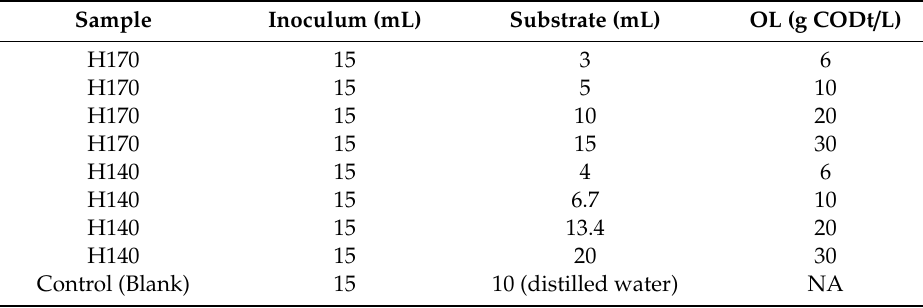
Table 4. Organic loading (OL) of batch syringes fed HWE hydrolysates.